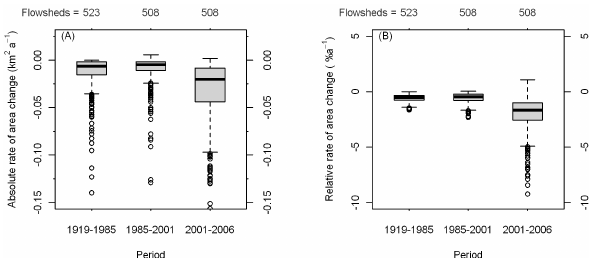
Fig. 7. (A) Absolute and (B) relative rates of area change for glaciers in the Canadian Rocky Mountains, over three periods from 1919 to 2006. Boxes represent the first and third quartiles; the hor- izontal black line is the median. The whiskers represent data ex- tremes (5th and 95th percentiles) and the circles are outliers (data outside the 5th and 95th